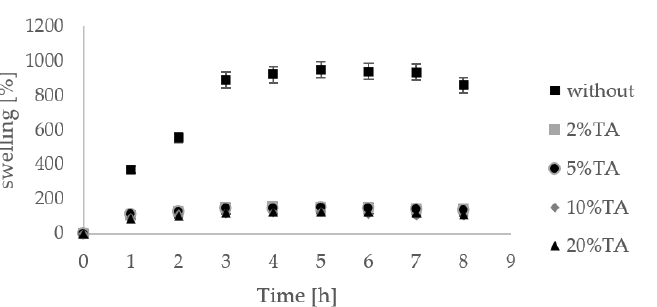
Figure 8. Swelling [%] of hydrogels (n = 3) without immersion in TA and after immersion in TA solution at 2%, 5%, 10%, and 20% concentration.